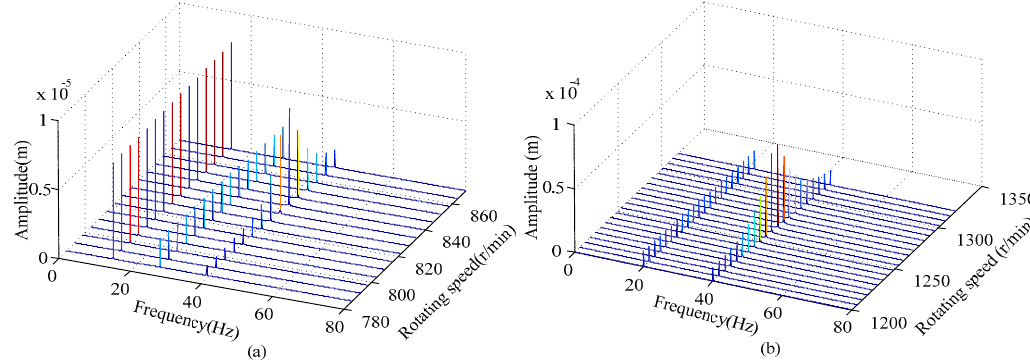
Figure 3. Waterfall diagram of the two-disc rotor ( a ) rotating speed near 1/3 critical speed; ( b ) rotating speed near 1/2 critical speed.